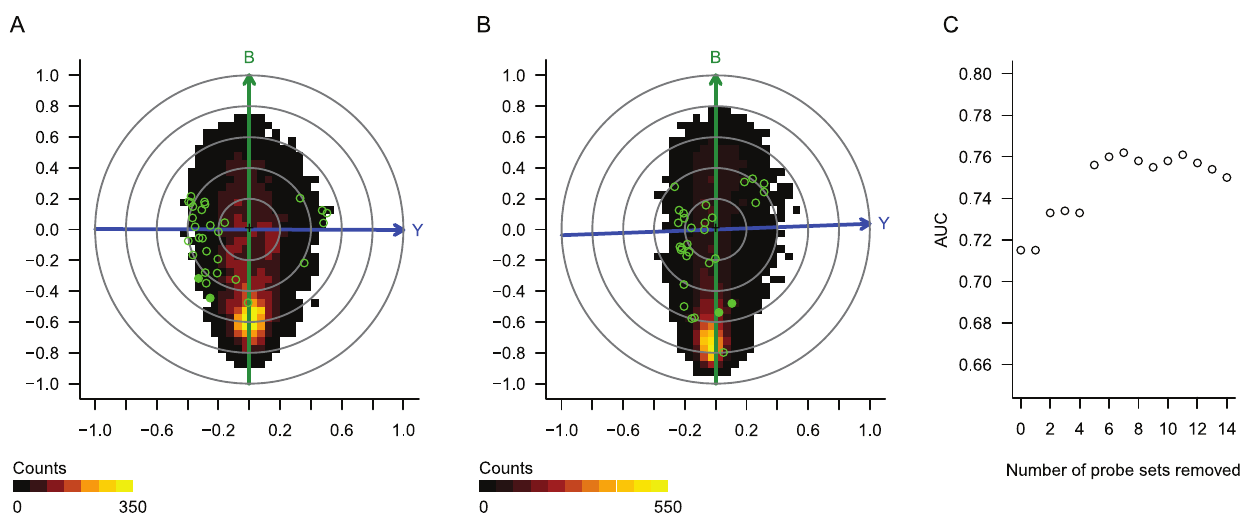
Figure 3. Case study 2: Breast tumors treated with neoadjuvant paclitaxel, fluorouracil, doxorubicin, and cyclophosphamide. A) Biasogram representing the training cohort of 133 tumors. B) Biasogram representing the independent validation cohort of 100 tumors. In both biasograms, Y indicates the outcome vector (tumor response), B indicates the bias vector (fraction of present calls), and the colorgram indicates a bivariate histogram of 22,283 expression values. The green open or filled circles indicate probe sets in the DLDA30 signature, with the filled circles indicating probes that, when omitted, improved the predictor’s performance. C) Chart indicating area under the curve (AUC) in the validation cohort for predictors derived with the indicated number of bias-correlated probe sets omitted.